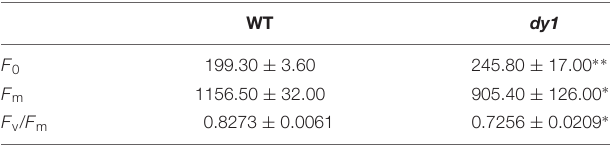
TABLE 2 | Chlorophyll fluorescence parameters in the leaves of the dy1 mutant and the wild-type (WT) plants grown under 100 µ mol m − 2 s − 1 . WT dy1 F 0 199.30 ±